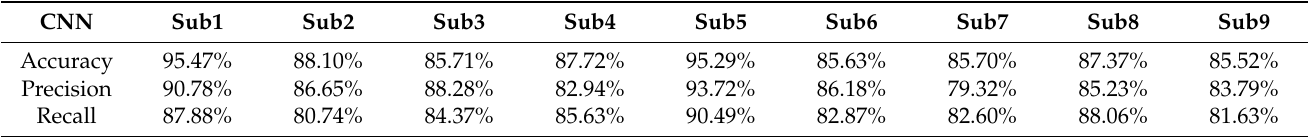
Table 2. Accuracy, precision, and recall of deep-learning (DL) algorithm, convolutional neural network (CNN) for all nine subjects.